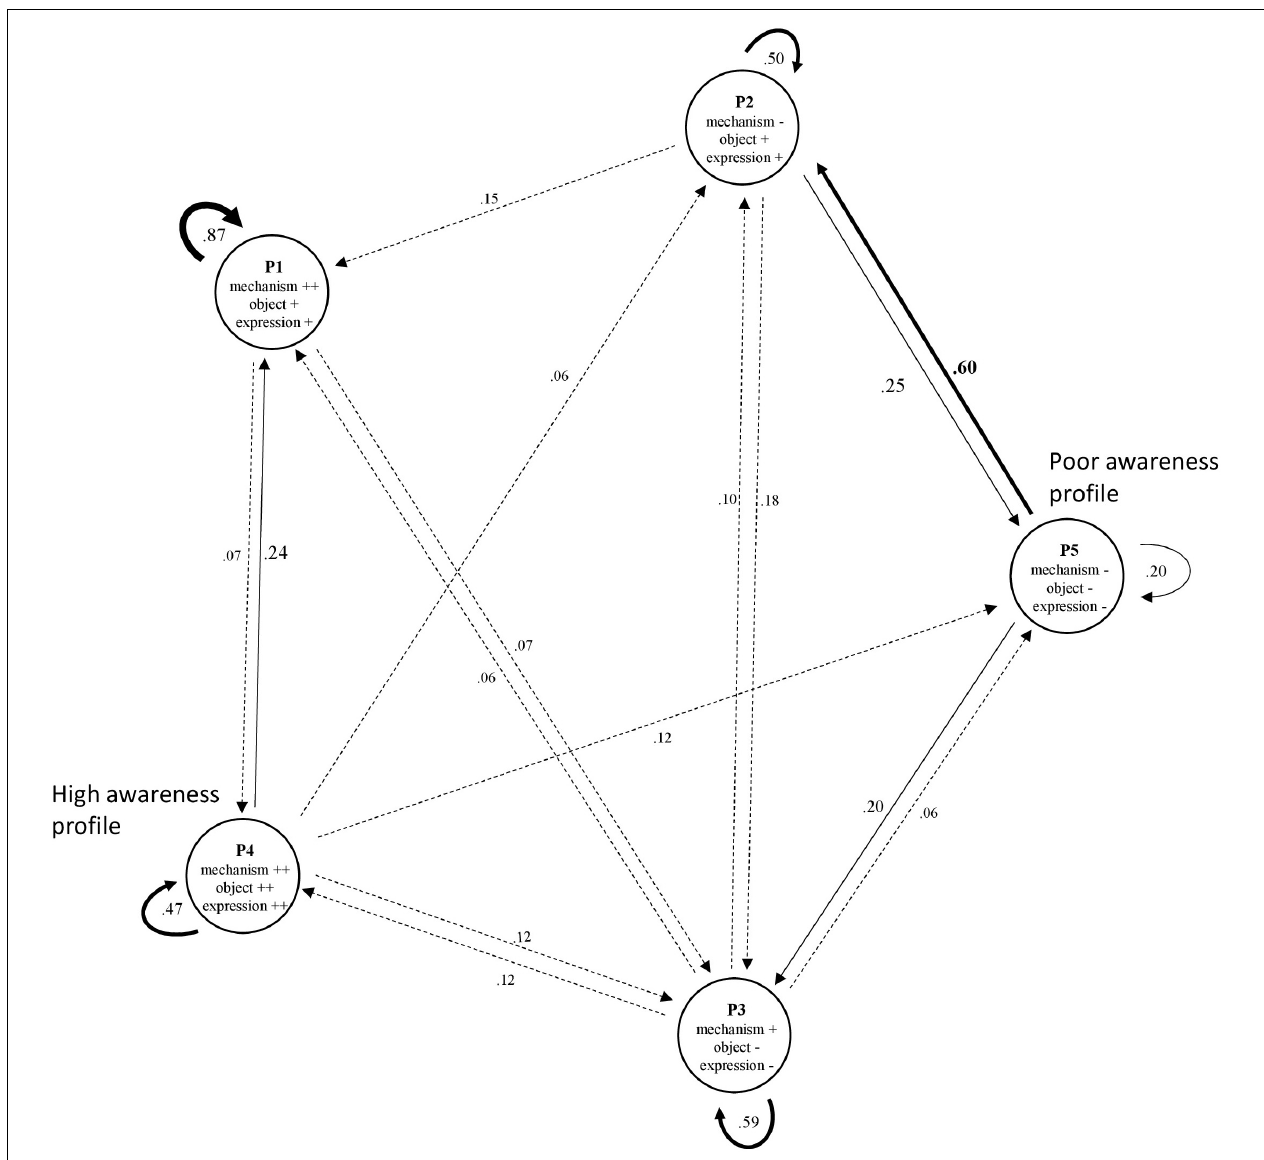
FIGURE 1 | Modeling of fluctuations in profiles of awareness by Markov chain. P, Profile; Mech, Mechanisms; Exp, Modes of expression. For ease of reading, the connections are coded according to the probability of the transition (dashed < 0.2; normal < 0.4 and bold > 0.4), as are the font sizes of the coefficients. The absence of a connection between two profiles is explained by the low occurrence or absence of a